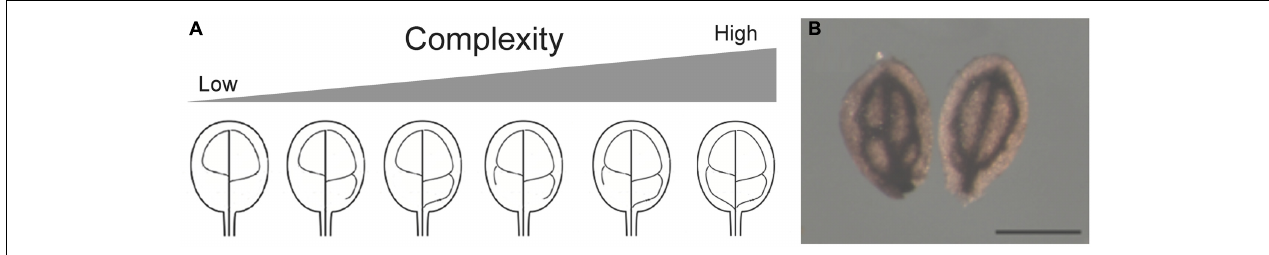
FIGURE 2 | (A) Arabidopsis cotyledon provasculature complexity. Different provasculature patterns found in wild type embryos are shown. (B) Cotyledons with different provasculature complexities have the same size. Mature wild-type cotyledons were stained with Perls/DAB to detect iron accumulation around the provasculature. Bar, 50 µ